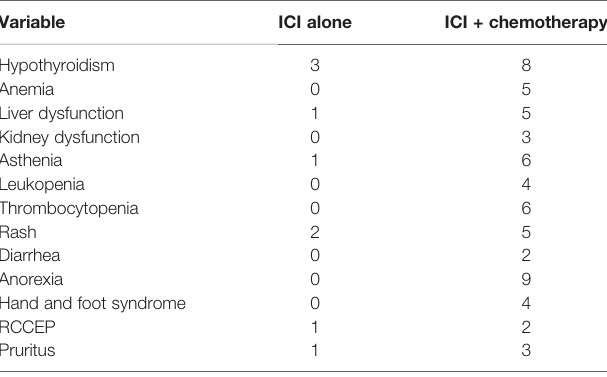
TABLE 3 | Adverse events in the study. Variable ICI